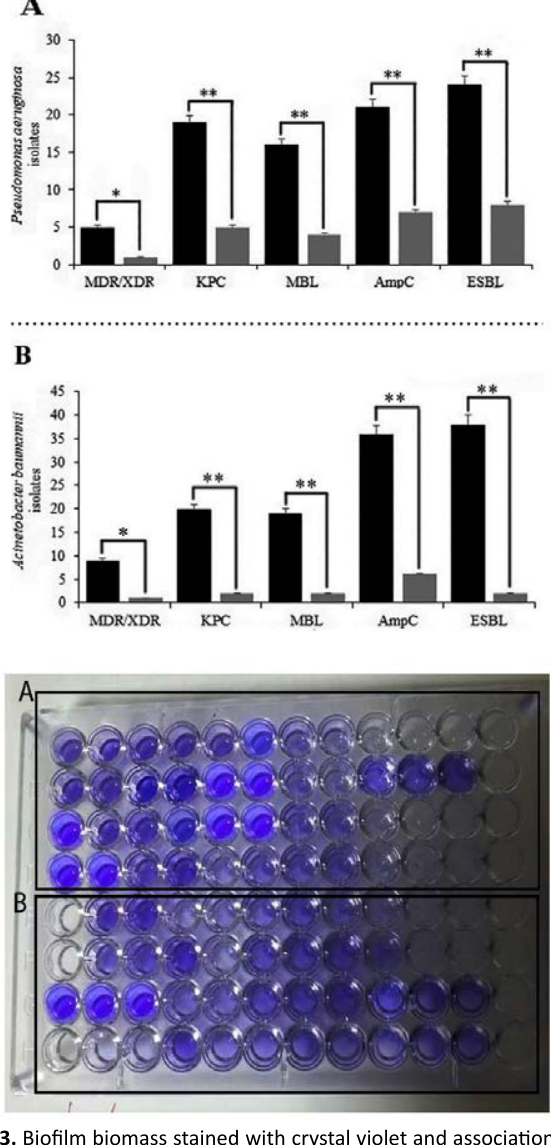
Fig. 3. Biofilm biomass stained with crystal violet and association of biofilm formation and β-lactamase enzymes in P. aeruginosa (A) and A. baumannii (B). Biofilm biomass is measured in absorbance at 570nm; Black well: Biofilm forming strains; Clear well: Strains without biofilm. Error bars indicate standard errors of the means from a representative triplicate time. Mann–Whitney U test and χ 2 test was performed for testing differences between groups. *: p < 0.05, **: p < 0.001,